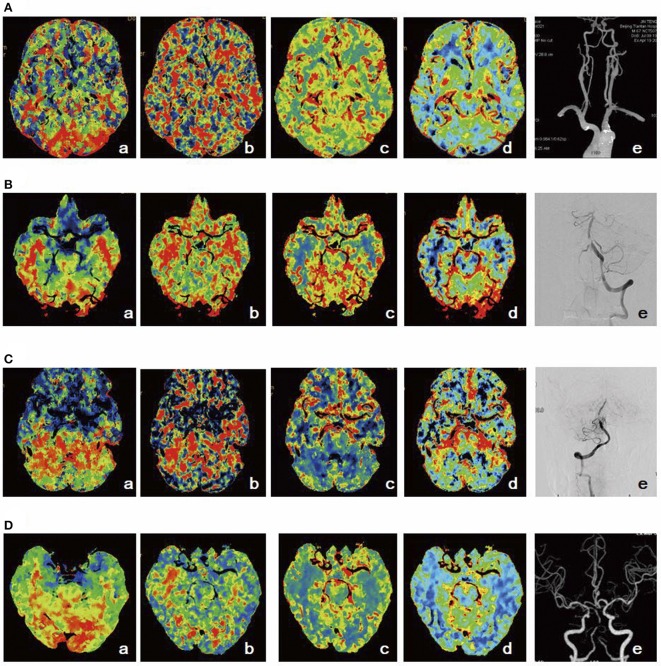
Schematic diagram of posterior circulation perfusion. (A) Stage I1: TTP was prolonged (a), MTT (b), CBF (c), and CBV (d) were normal, and CTA suggested severe stenosis of the left vertebral artery opening (e). (B) Stage I2: TTP (a) and MTT (b) were prolonged, CBF was slightly decreased (c), CBV was elevated (d), and DSA indicated severe proximal stenosis of the basilar artery (e). (C) Stage I3: TTP (a) and MTT (b) were prolonged, CBF was decreased (c), CBV was slightly decreased (d), and DSA indicated severe stenosis in the middle part of the basilar artery (e). (D) Stage I4: TTP (a) and MTT (b) were prolonged, CBF was decreased (c), CBV was decreased (d), and CTA demonstrated occlusion in the middle part of the basilar artery (e).